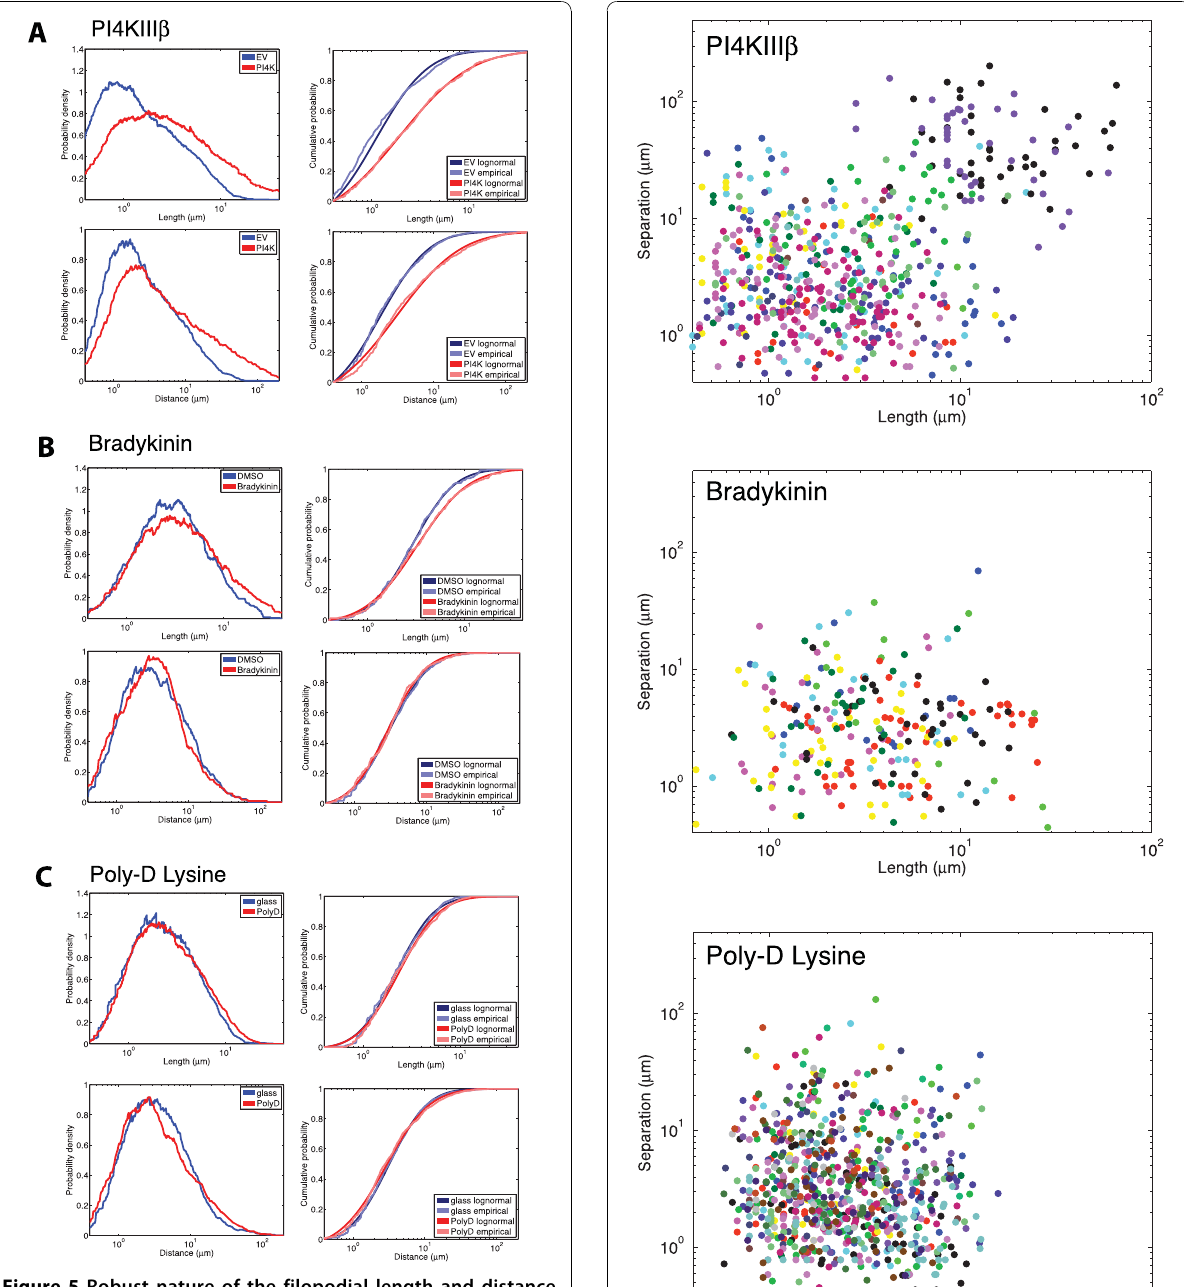
Figure 5 Robust nature of the filopodial length and distance separation lognormal distribution . Perturbation analysis of Rat2 cells after genetic, chemical and physical induction of filopodia. (A) P П I4KIII b expression induces filopodia and increases both length and separation distance relative to the empty vector control. Rat2 cells stably expressing PI4KIII b and controls have been previously described [22]. (B) Bradykinin, a chemical inducer of filopodia, increased the length but had no effect on the interfilopodial distances compared to the DMSO control. Rat2 cells were treated with 100 ng/mL bradykinin. (C) Poly-D-lysine, a physical inducer of filopodia, increased the length of filopodia modestly but had no effect on distances.